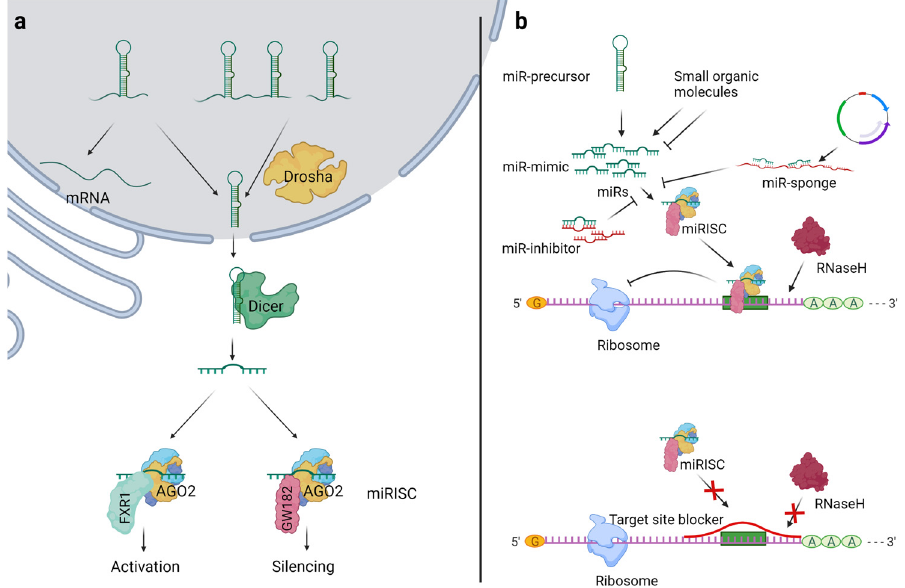
Figure 1. Overview of miR biogenesis and general strategies for miR modulation. ( a ) Drosha processes the primary miRs (pri-miRs) to precursor miRs (pre-miRs) in the nucleus, which are then transported to the cytosol by exportin 5. In the cytosol, the Dicer cleaves the pre-miRs to mature miRs. The miRs bind to argonaute-2 (AGO2), which interacts with GW182 to inhibit the target gene’s translation in a sequence-specific manner. In specific conditions such as starvation, AGO2 interacts with FXR1 and initiates the gene translation in a sequence-specific manner. ( b ) The use of miR mimics or miR precursors increases the levels of mature miRs. The miR inhibitor or miR sponge sequesters miRs and decreases their availability for miRISC loading. The target site blockers block the binding site of miR on the specific target mRNA, leading to mRNA-specific inhibition of the miR effects.